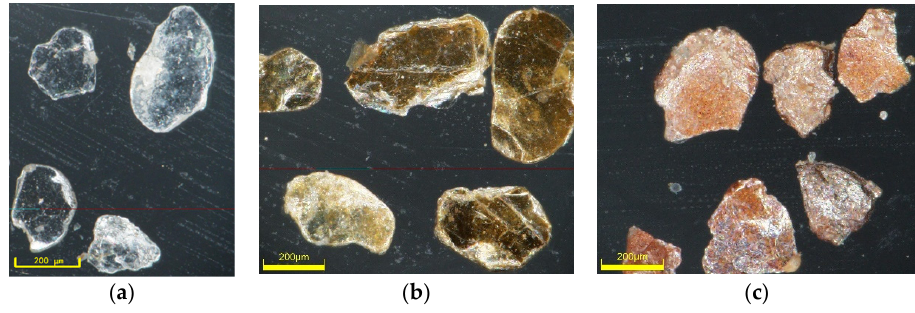
Figure 2. Muscovite ( a ), biotite ( b ) and weathered mica ( c ) under the microscope. The particle percentages of biotite, weathered mica, and muscovite were separately calculated as follows: particle percentage of biotite or weathered mica or muscovite = 100% * particle number of biotite or weathered mica or muscovite/total particle number of mica. Additionally, the mass percentage of mica was calculated as follows: mass per- centage of mica = 100% * total mica mass/total mineral mass.